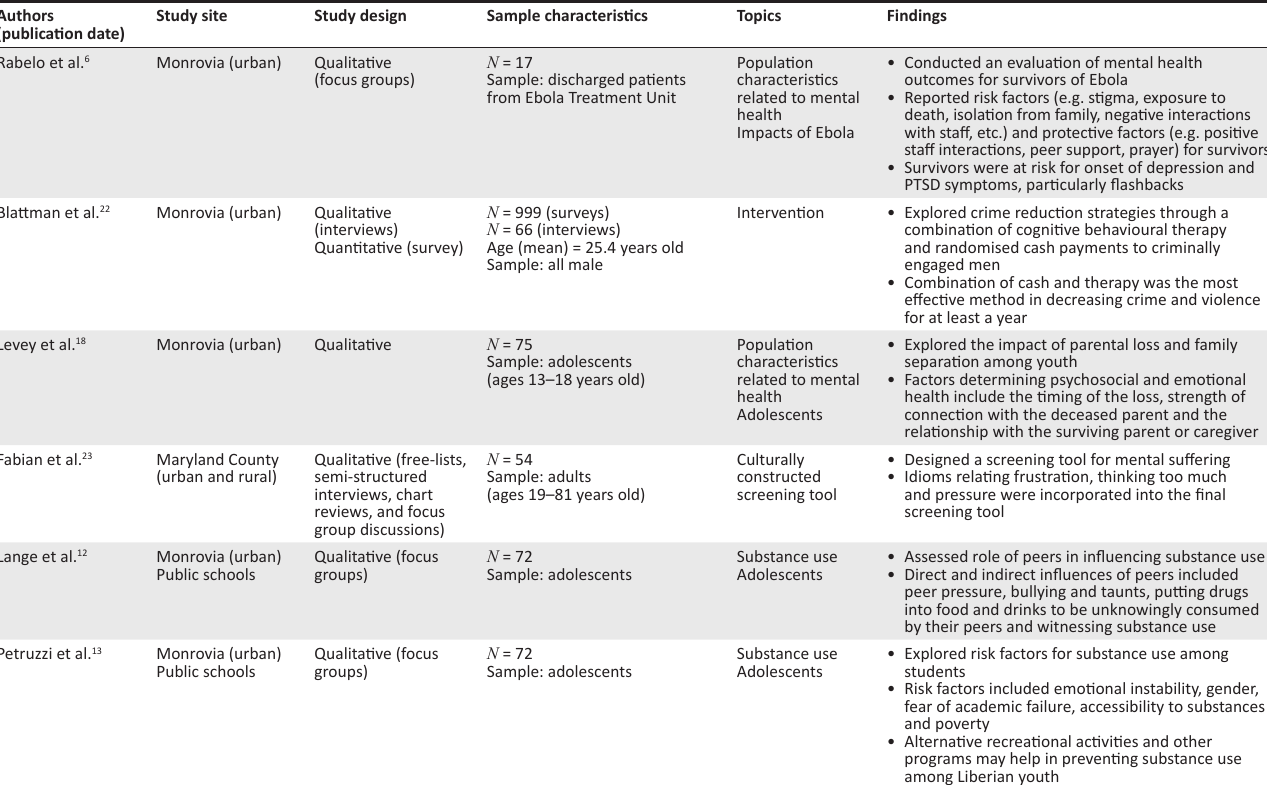
TABLE 1 (Continues...): Overview of included articles.